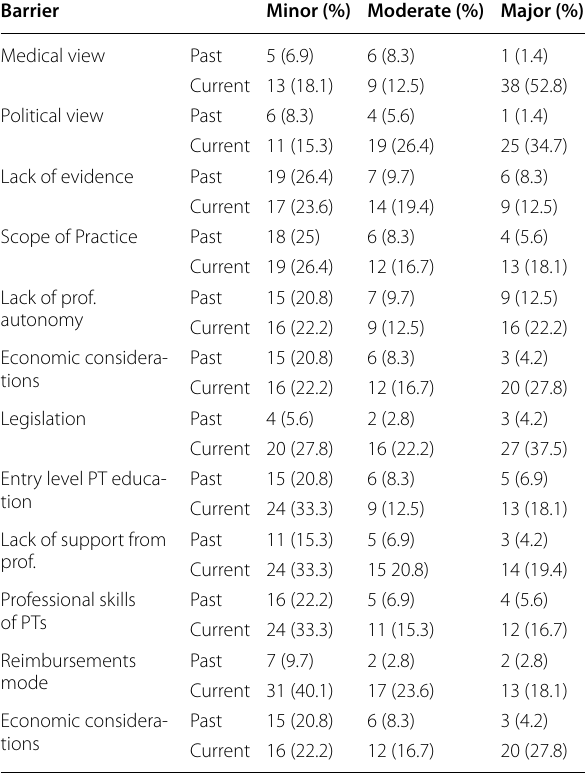
Table 7 Past and current barriers to first contact physiotherapy